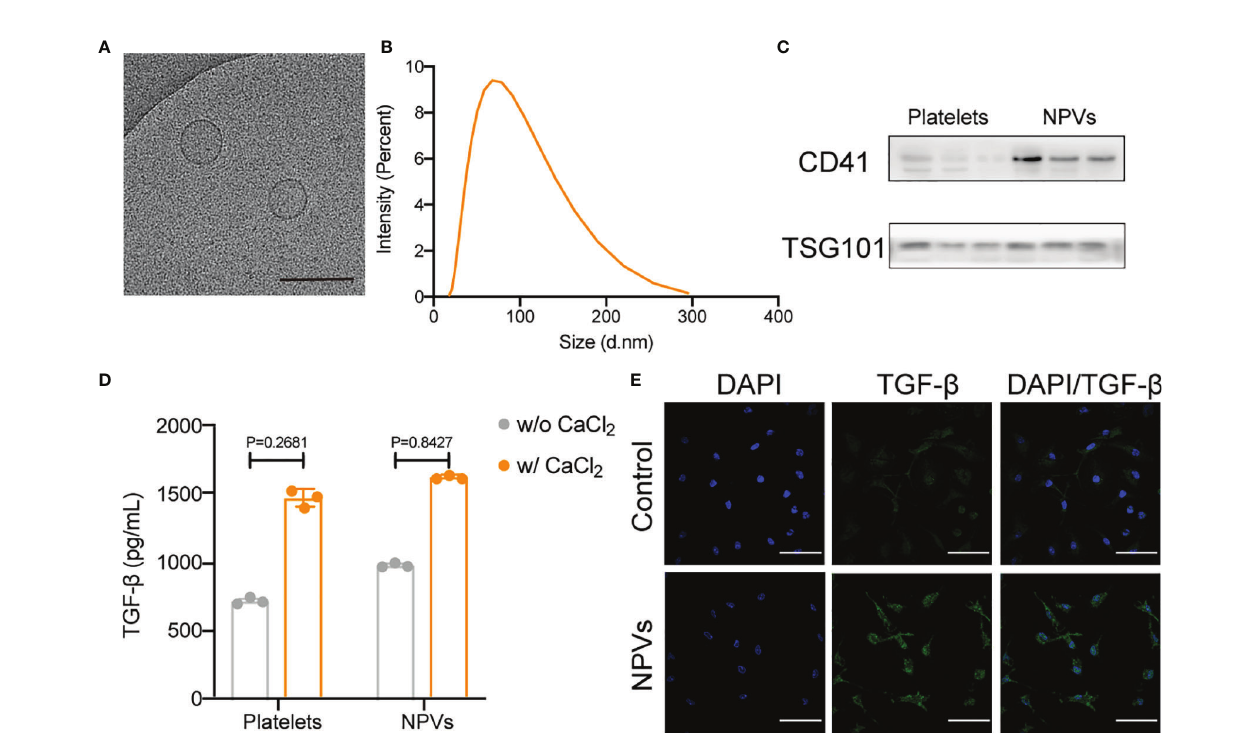
FIGURE 1 | Characterization of NPVs. (A) Representative cryo-TEM images of NPVs. (Scale bar; 1 bar represents 200 nm) (B) Size distribution of NPVs obtained using DLS, NPVs are on average about 68 nm wide. (C) The expression of CD41 on NPVs was detected by western blot, and TSG101 was used as an internal reference. (D) ELISA detection of TGF- b content in platelets and NPVs. (E) Immunostaining of M1 macrophages after treatment with phosphate buffered saline (PBS) or NPVs. (Nuclei, blue; TGF- b , green) Scale bar = 100 m m, n = 3 per group.